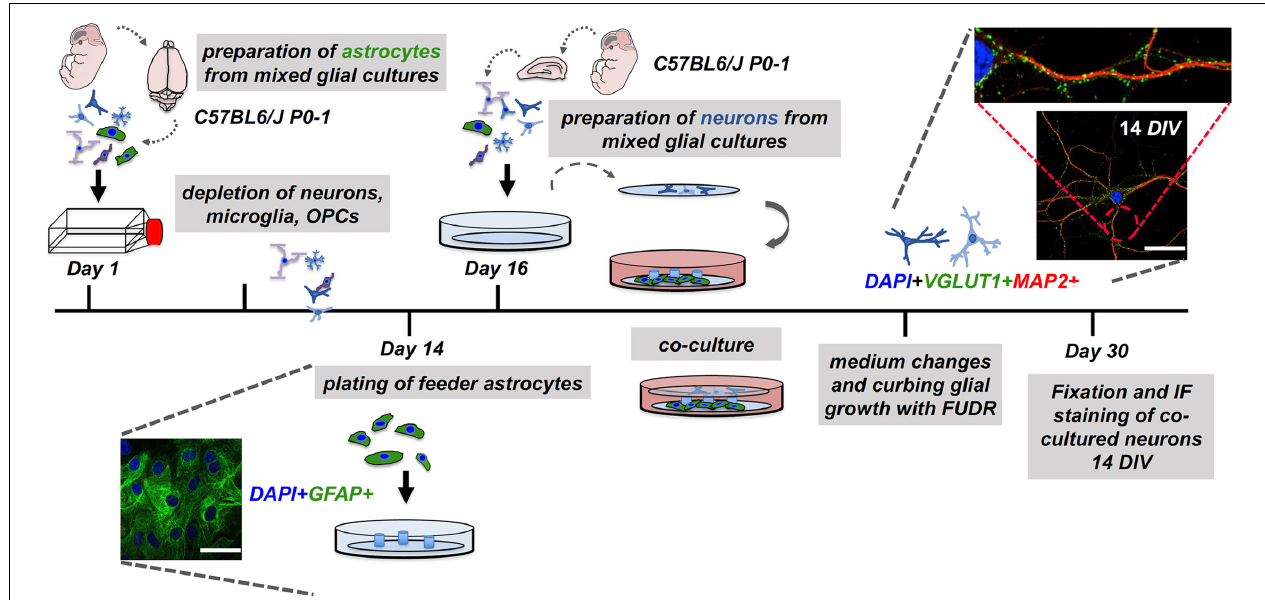
FIGURE 1 | Workflow of the neuron-astrocyte co-culture assay. To set up a neuron-astrocyte co-culture the following steps are necessary: Preparation of mixed CNS cells (dissection #1) for preparation of astrocyte feeder cells cultures must be performed 14 days in advance. The second dissection (dissection #2) of mixed CNS cells served the neuronal cell layer. Here, CNS cells were plated on pre-treated and coated glass coverslips and inverted over the feeder layer. The resulting co-cultures were carefully monitored and treated for the reduction of glia contaminations in the neuronal layer. Co-cultures were subjected to downstream experiments after 14 days in co-culture, which is corresponding to day 30 after the experiment was started. Representative confocal images of neuronal (MAP2), synaptic (VGLUT1), and astrocyte (GFAP) markers are shown (nuclei/DAPI in blue), scale bar = 50 µ m.